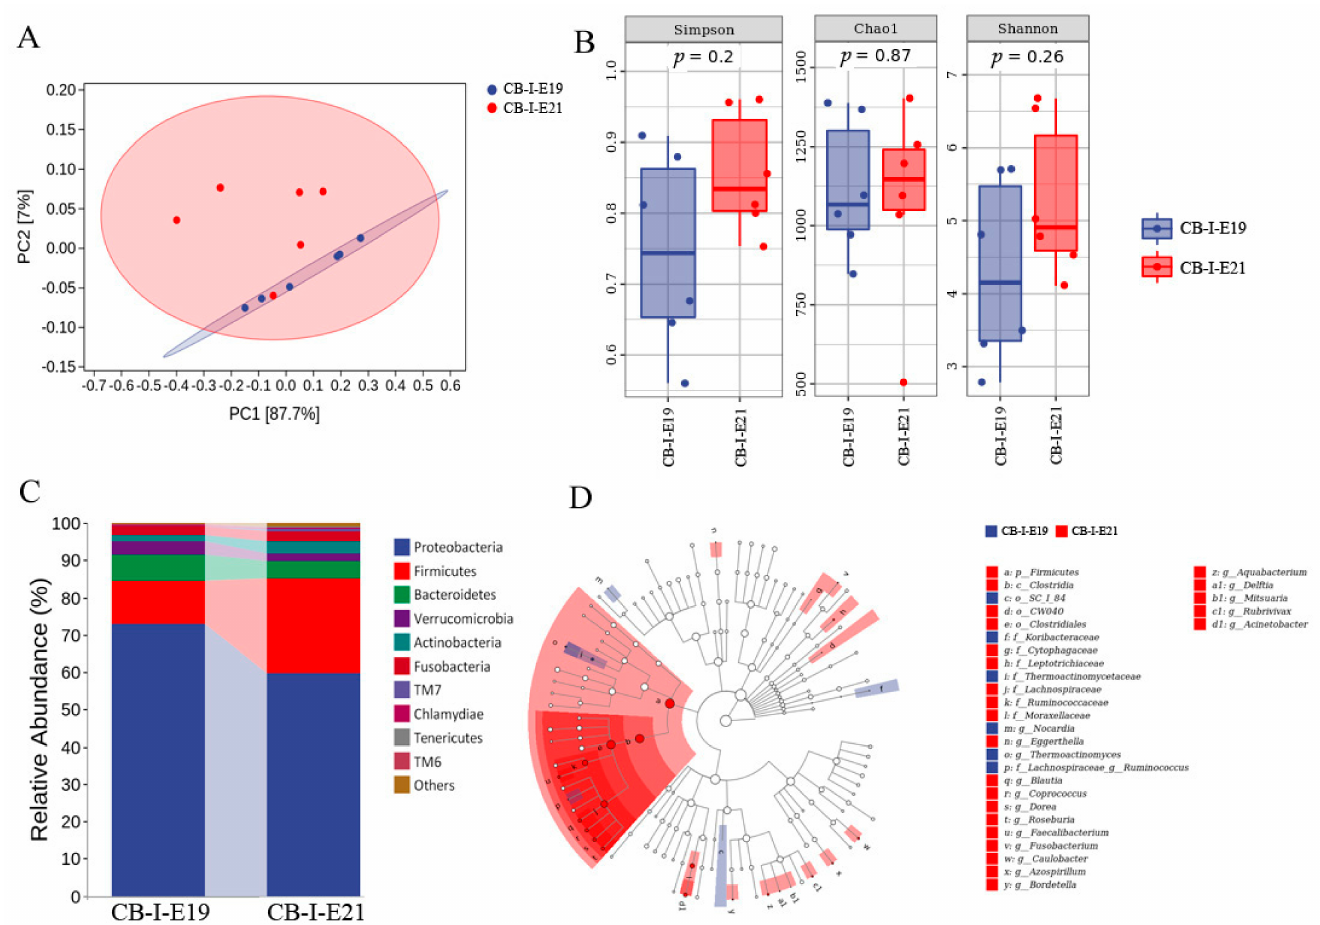
Figure 5. Early changes of intestinal microbiota in chicken embryos. ( A ) PCA: Each point represents a sample, and points of different colors indicate different groups. ( B ) Each panel corresponds to an alpha diversity index, which is identified in the gray area at the top. In each panel, the abscissa is the group label, and the ordinate is the value of the corresponding alpha diversity index. ( C ) The relative abundance of intestinal microbiota at E19 and E21 (at the phylum level). ( D ) Taxonomic cladogram generated from LEfSe showing significant difference in the microbiota profile of intestinal microbiota at E19 and E21. CB in the picture represents commercial broilers and I represent